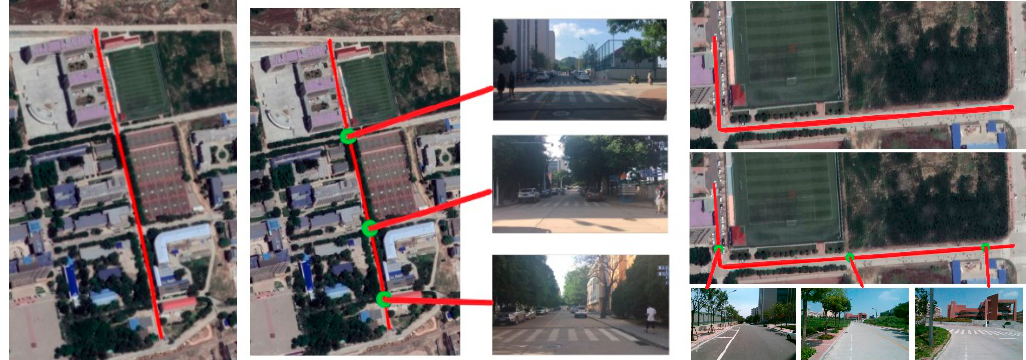
Figure 11. The driven routes and the places of the nodes for visual matching.